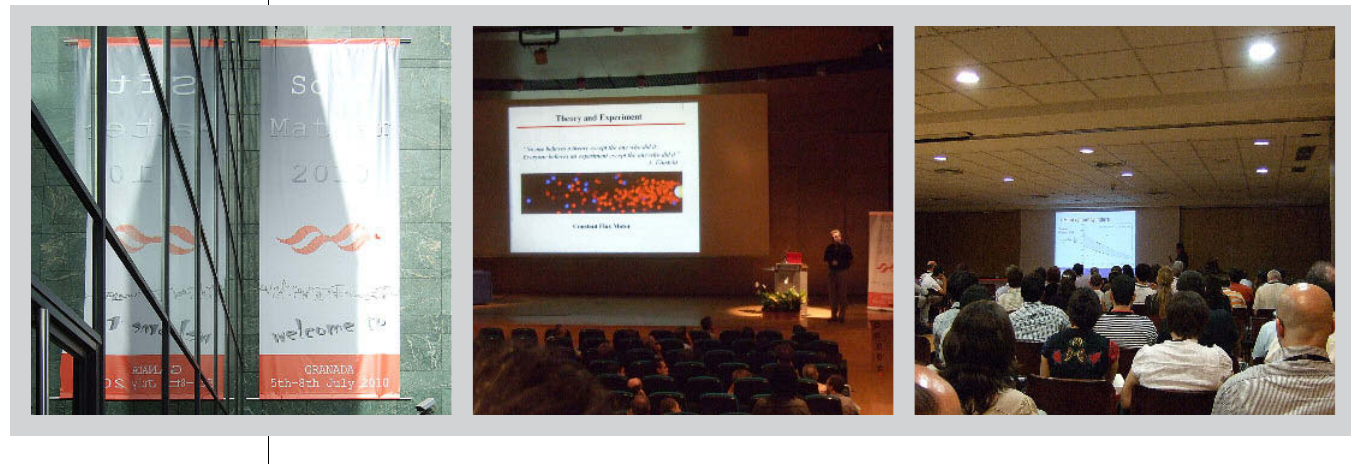
Figure 1 (left): Granada Exhibition Confe- rence Centre – venue of the ISMC 2010. Figure 2 (middle): Granada Exhibition Confe- rence Centre – venue of the ISMC 2010. Figure 3 (right): Group photo of the ISMC